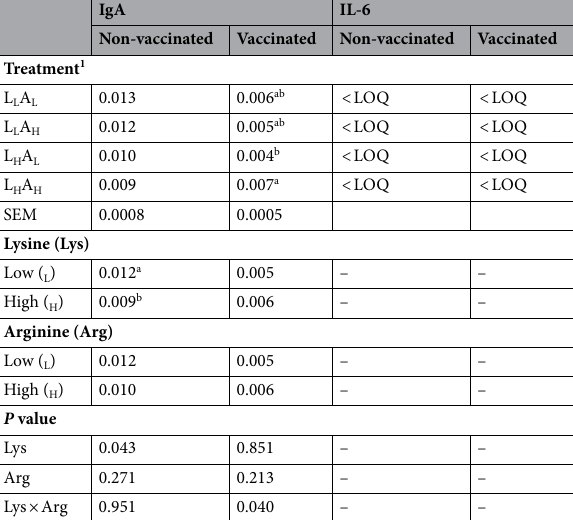
Table 6. The mRNA expression of selected genes in the liver of vaccinated and non-vaccinated turkeys at 6 weeks of age. 1 L L A L diet with low Lys and low Arg levels; L L A H diet with low Lys and high Arg levels; L H A L diet with high Lys and low Arg levels; L H A H diet with high Lys and high Arg levels. IgA: immunoglobulin A. IL-6: interleukin; < LOQ- below the limit of quantification. a,b Values in same column with no common superscripts denote a significant difference (P ≤